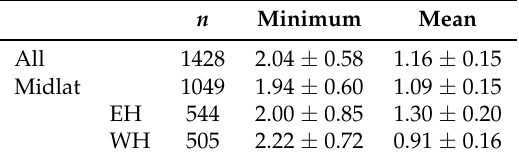
Table 1. Mean temperature increase across stations (°C), 1970–2016. Minimum: annual minimum temperature. Mean: annual mean temperature. Midlat: northern midlatitudes, 30°–60°N. EH: Eastern Hemisphere. WH: Western Hemisphere. n : Number of stations. Confidence intervals of 95% are given.